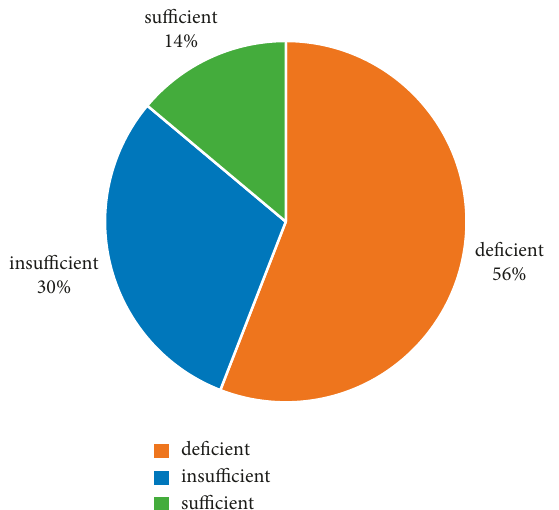
Figure 1: Pie chart showing the distribution of vitamin D status in Eastern